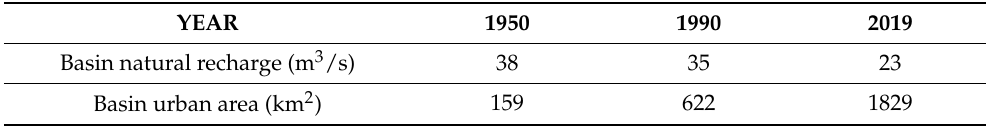
Table 2. Effective recharge rate and urban